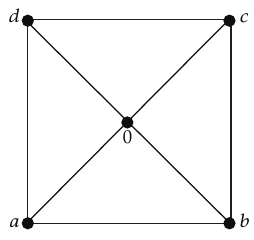
Figure 2: Associated graph Γ(cid:2) X (cid:3) of X .